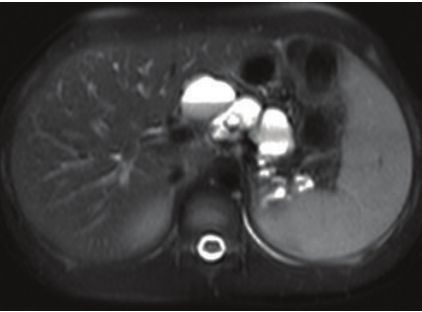
Figure 2: T2-weighted fat-saturated transverse MR image also shows multiple high signal, cystic lesions of various size at the expectedregionofthebodyofthepancreas.Notethefluid-fluidlevel in the largest